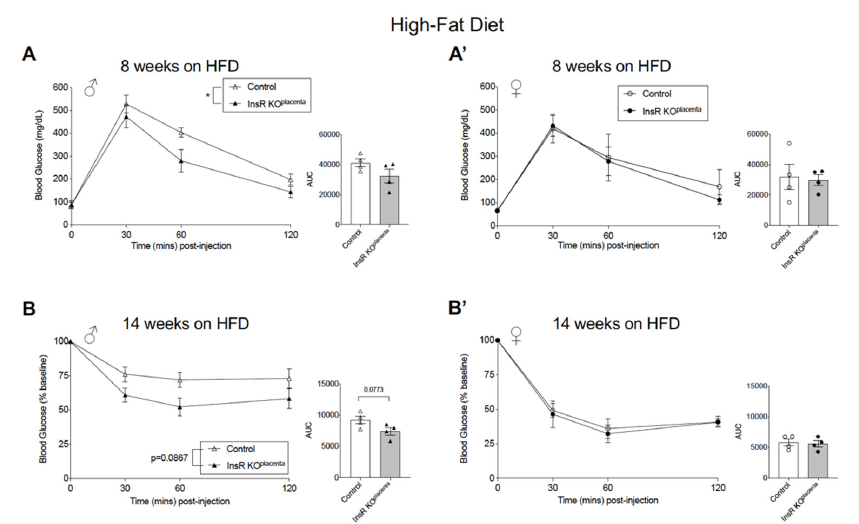
Figure 4. Adult male InsR KO placenta mice from multiparous dams presented with a mild and transient improved glucose homeostasis on a high-fat diet challenge. ( A ) IPGTT and AUC analysis (right) for the male ( n = 4) and ( A’ ) female ( n = 4) mice from parity ≥ 3 at 8 weeks on a HFD. Repeated measures two-way ANOVA revealed significant differences ( p = 0.0332) between the InsR KO placenta and control males at 8 weeks on a HFD. A separate unpaired t -test performed specifically for T = 60 min revealed p = 0.0593. ( B ) IPITT and AUC analysis (right) for the males ( n = 4) and ( B’ ) females ( n = 4) from parity ≥ 3 at 14 weeks on a HFD. Blood glucose values for IPITT are expressed as the baseline percentage of blood glucose. Repeated measures two-way ANOVA analysis revealed a p -value of 0.0867 in the males at 14 weeks on a HFD. A separate unpaired t -test performed specifically for T = 30 and T = 60 min revealed p = 0.0843 and p = 0.0600, respectively. The values are reported as the means ± SEM, * p < 0.05.